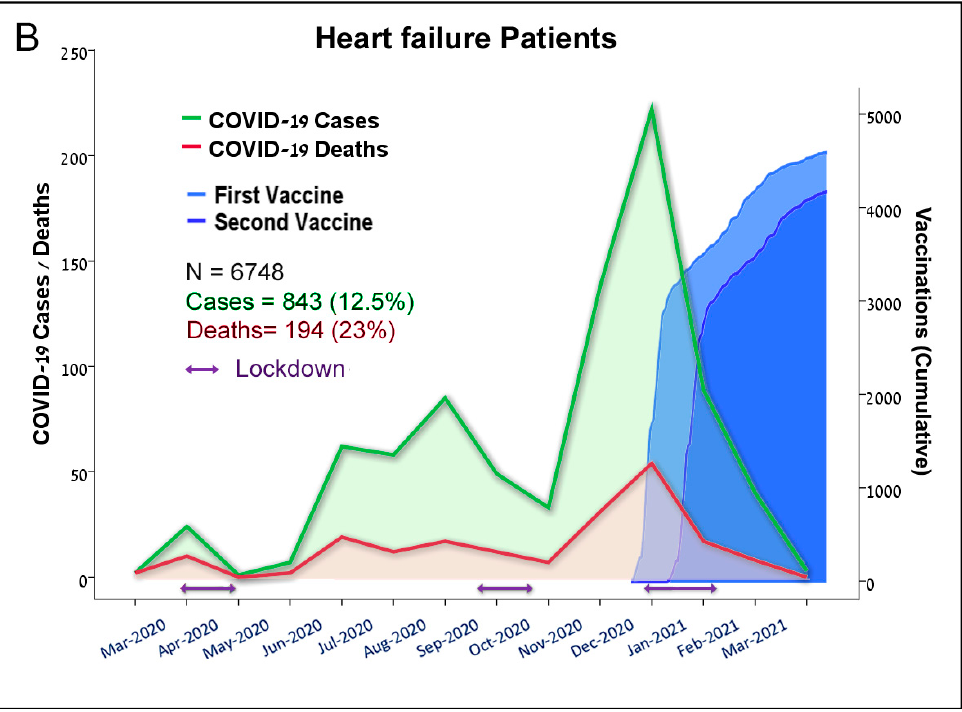
Figure 1. Timeline of 2020/2021 COVID-19 pandemic in Israel. ( A ) Three COVID-19 infection waves in the whole Israeli population as reported by the Israeli ministry of health and retrieved on 29 March 2021. Cases, deaths, and vaccinations are depicted. ( B ) Infection waves in the HF cohort. Data are depicted per month. Vaccination data are accumulative per day.